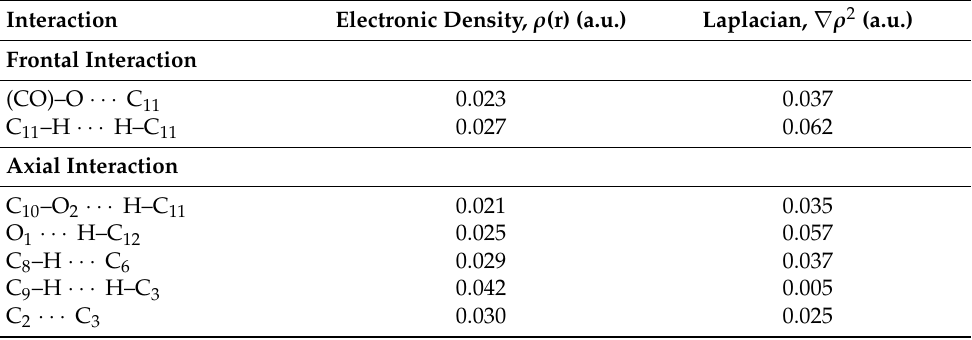
Table 5. Topological properties calculated on the molecular interactions in DADB at the bond critical point.